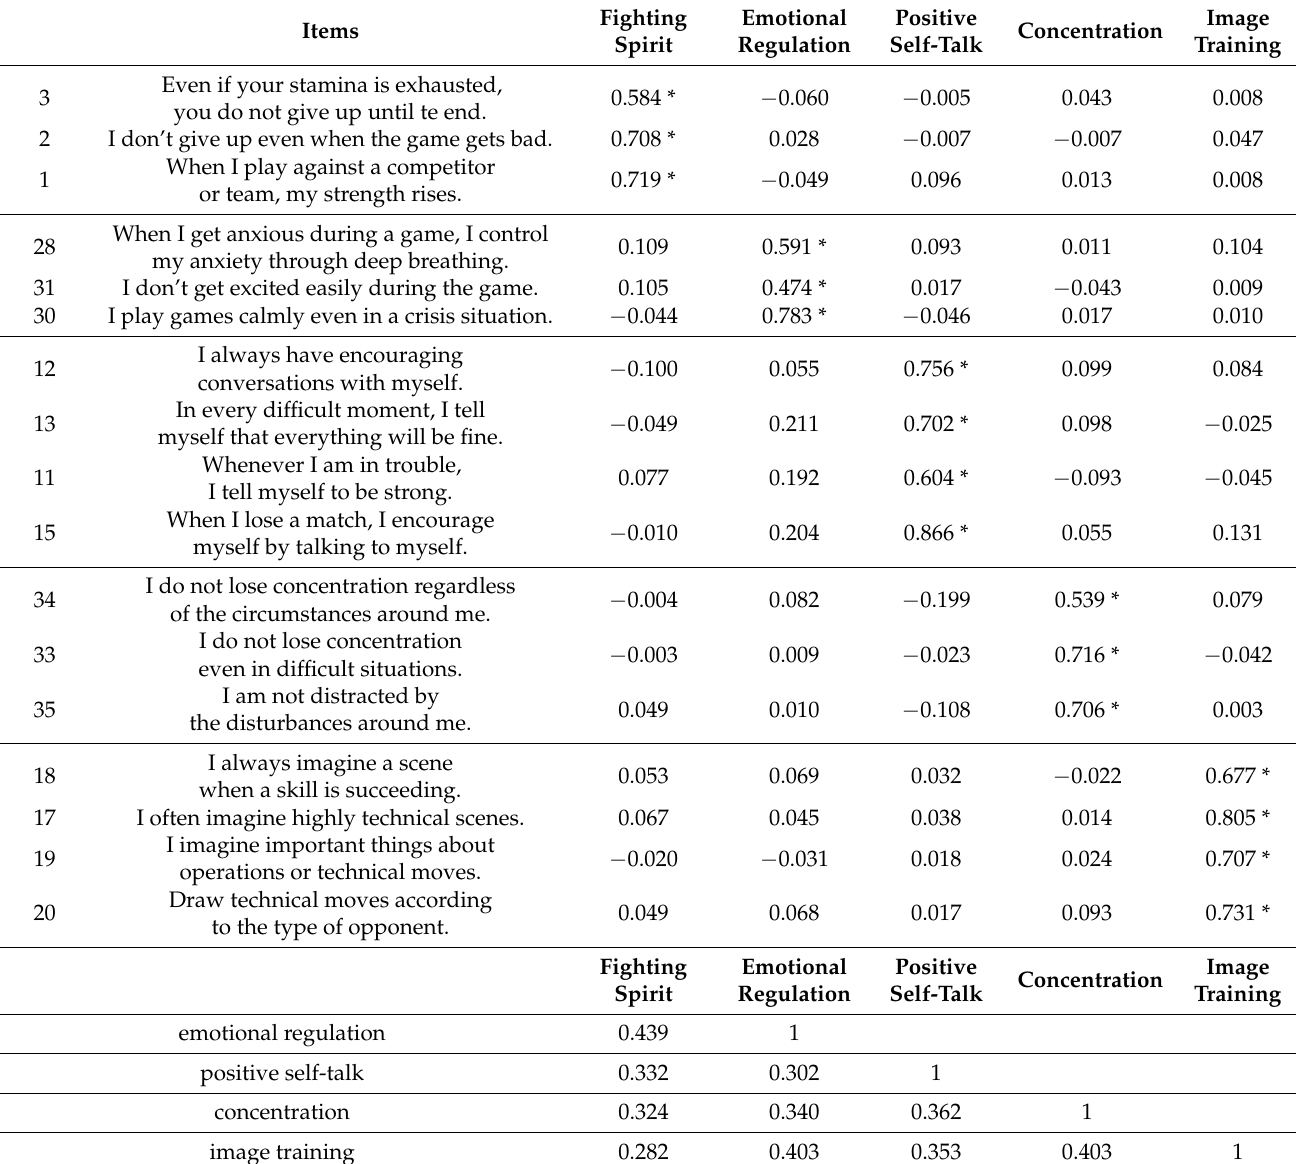
Table 11. Results of ESEM